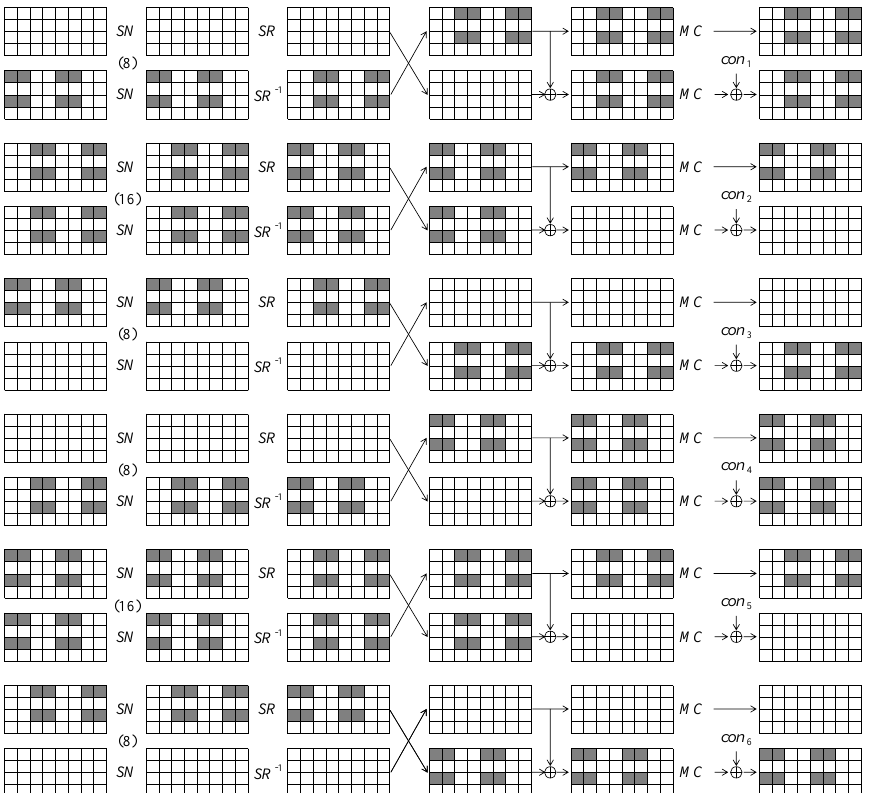
Figure 8: 6-round iterative truncated differential of Minalpher-P. Filled and empty cells denote active and inactive nibbles, respectively. Note that we rotated the original 6-round iterative characteristic by one round to optimize it in our